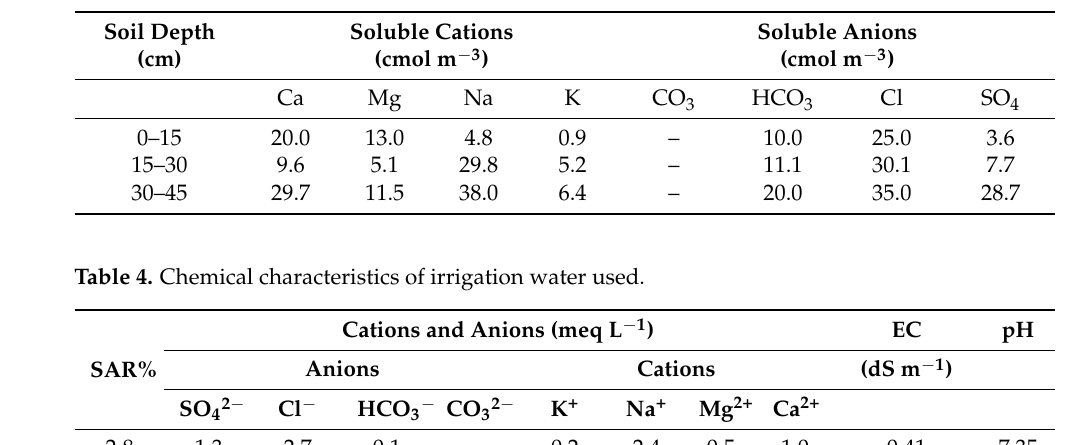
Table 3. Concentration of cations and anions of soil at the experimental site.